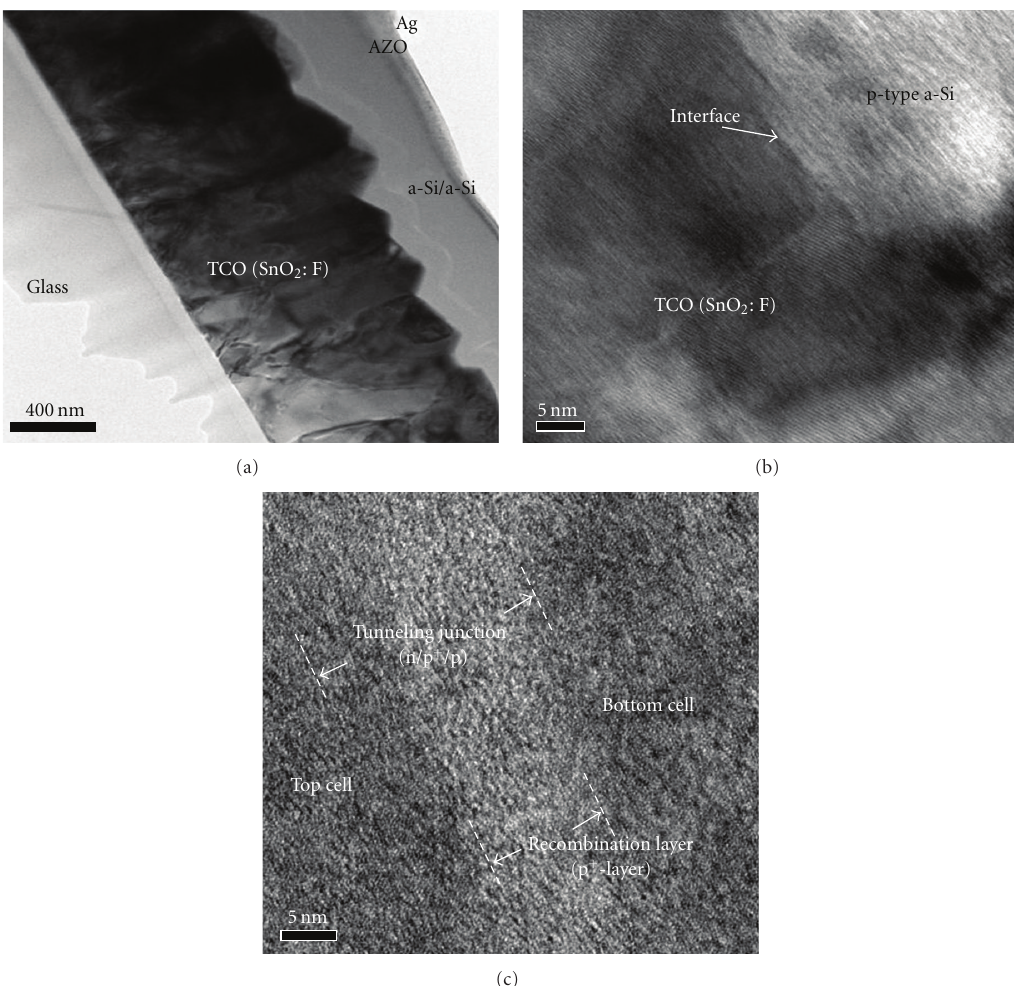
Figure 6: Cross-sectional transmission electron micrographs of (a) a-Si/a-Si tandem cell, (b) TCO/p interface, (c) n/ δ (p + )/p junction.